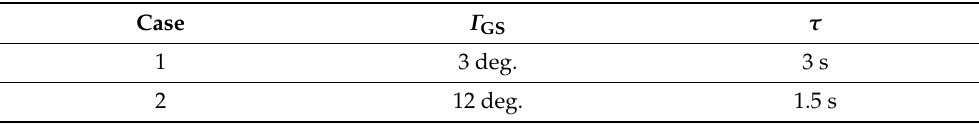
Table 7. Conditions of simulation for cases 1 and 2.